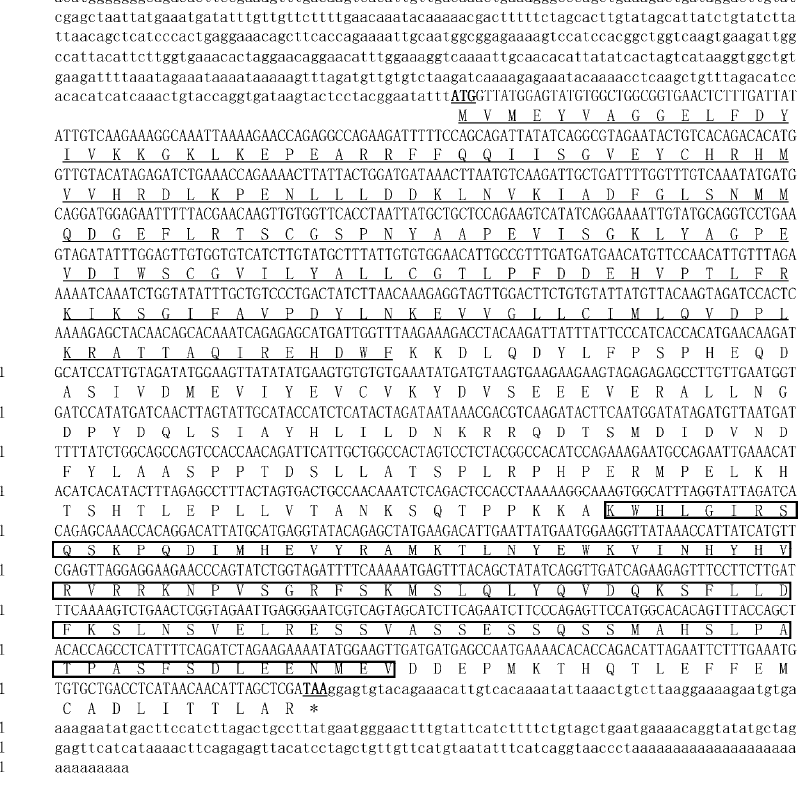
Figure 1. The nucleotide and predicted protein sequences of McAMPK α . The uppercase letters in cDNA represent the open reading frame (ORF), and the lowercase letters represent the 5 ′ and 3 ′ noncoding regions; * indicates stop codon. The start (ATG) and stop (TAA) codons are presented in bold and underlined. The same as below. Only underlined areas represent the S_TKc domain, and the black-framed regions represent the adenylate sensor domain.